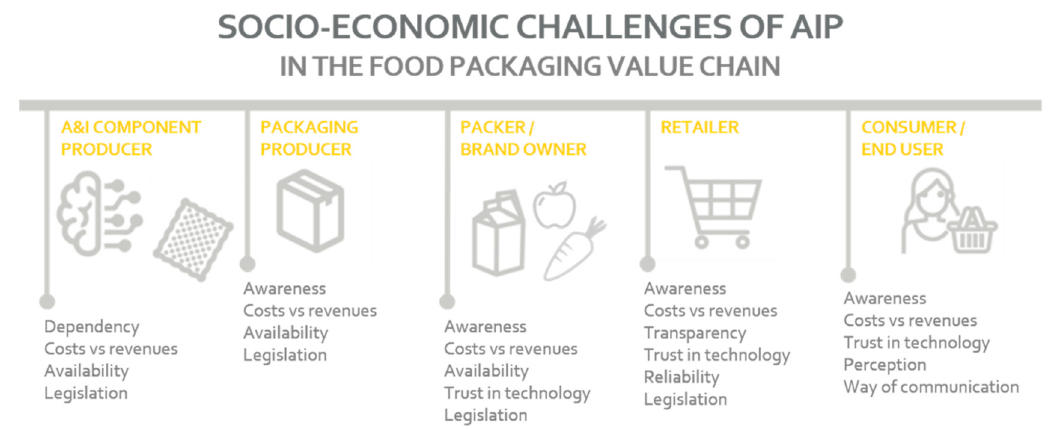
Figure 7. Overview of socioeconomic challenges for all different stakeholders in the AIP value chain [41].